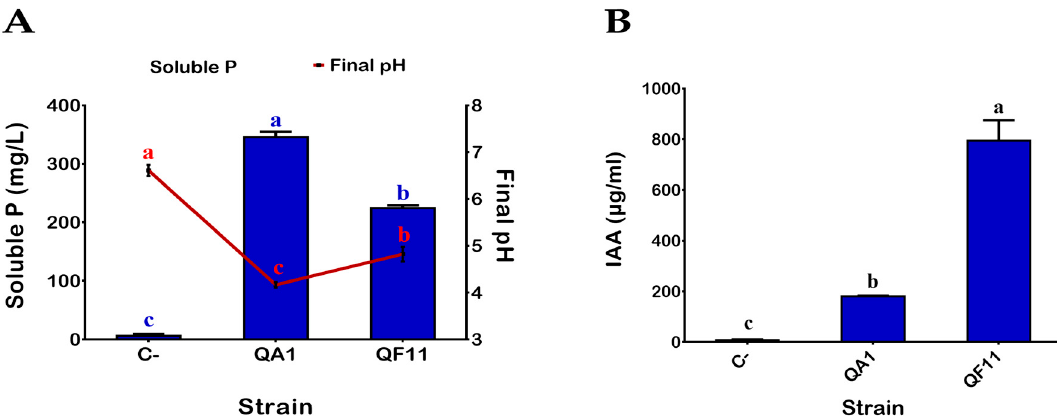
Figure 1. ( A ) Phosphate solubilization by selected PSB (phosphate solubilizing bacteria) in the presence of 0.5% hydroxyapatite in NBRIP broth. Drop in pH is indicated by the red line. ( B ) IAA (indole-3-acetic acid) production by selected PSB in the presence of 0.1% L-tryptophan. Uninoculated media were used as a negative control (C-). The values represent means of replicates ( n = 3) ± standard deviations. The different letters in superscript (a, b, c…) indicate the statistically significant difference at 95% between treatments.